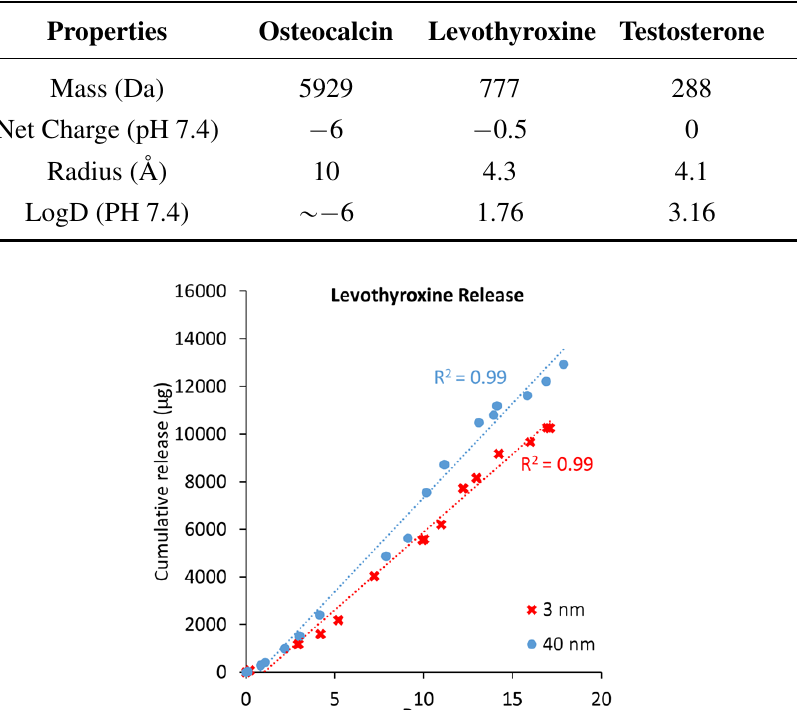
Table 1. Properties of released molecules. LogD: distribution ratio.